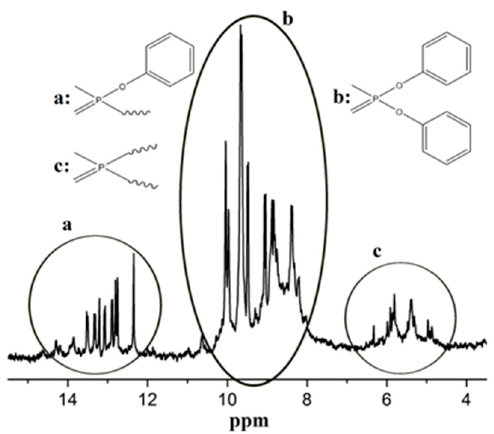
Figure 3. The 31 P NMR spectrum of the synthesized HSPCTP.